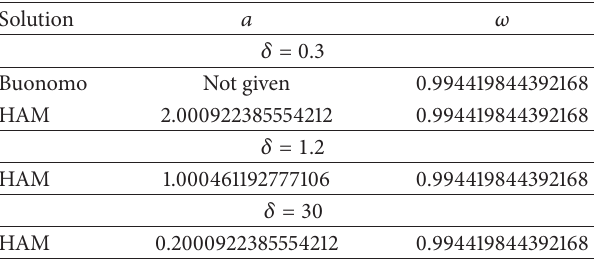
Table 2: The frequency and amplitude of the van der Pol equation with 𝜀 = 0.3 , by Buonomo’s and 100th-order HAM solution, respec- tively.